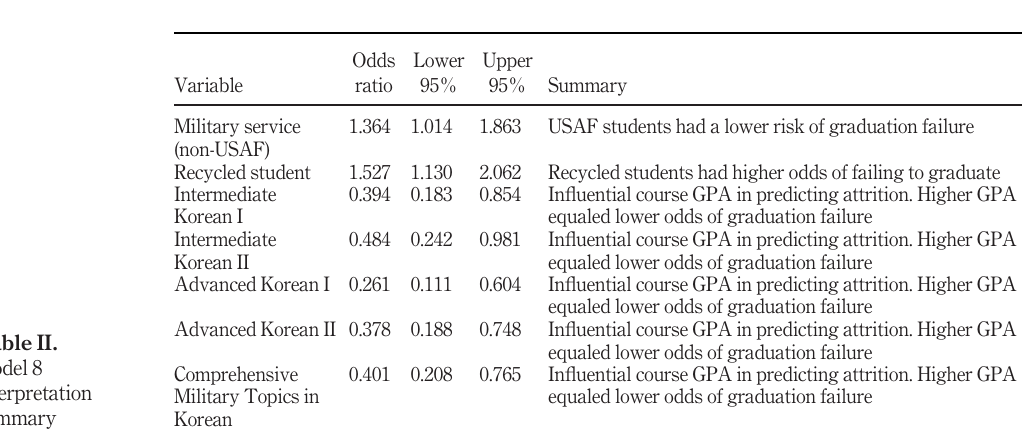
Table I. Model 5 interpretation summary